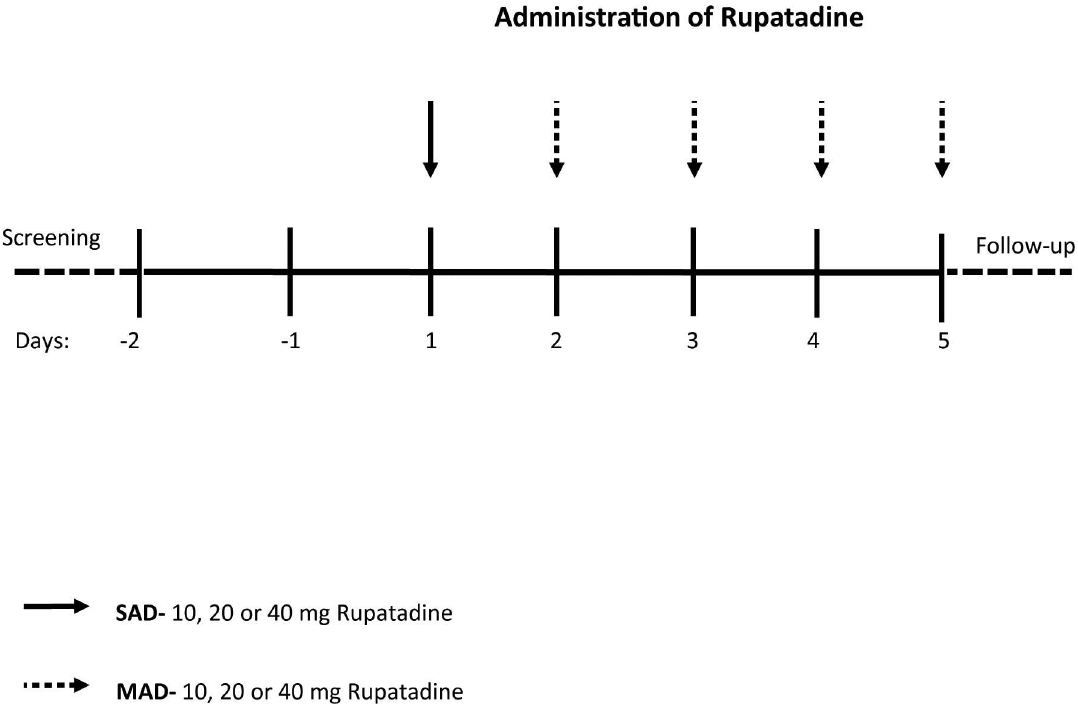
Fig 1. Study design. Schematicrepresentation of the study design.A single dose of rupatadine was given on Day 1 and multipleascendingdoses were administeredon days 2–5.